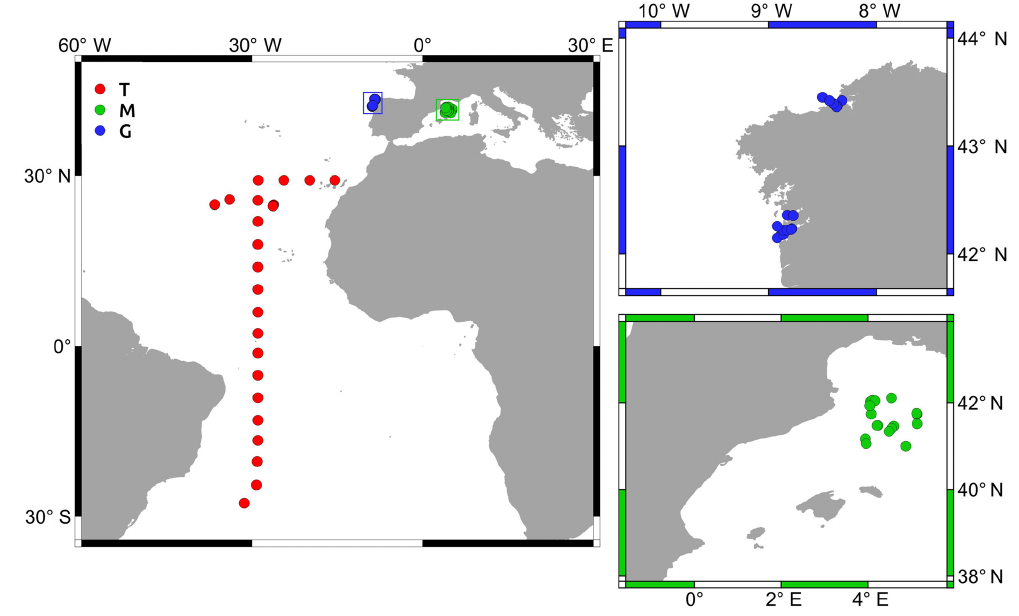
Figure 1. Location of the stations sampled in the tropical and subtropical Atlantic Ocean (T), the Mediterranean Sea (M), and the Galician coastal upwelling (G). Small panels provide details about those stations sampled in M (green) and G